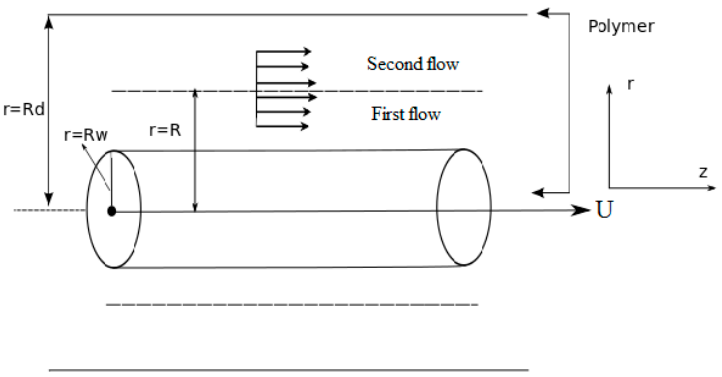
Figure 2. Geometry of double-layer optical fiber coating in wet-on-wet coating process